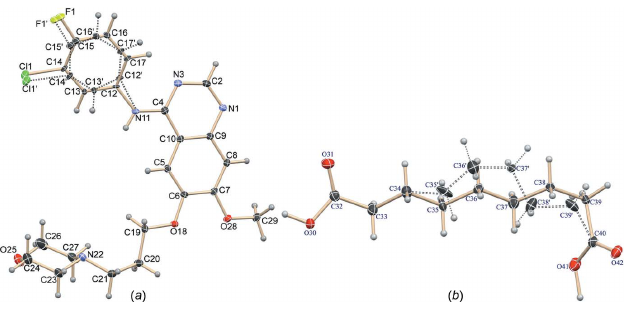
Figure 3 Structure overlay of GTB molecule in the co-crystal (magenta) and its stable polymorph